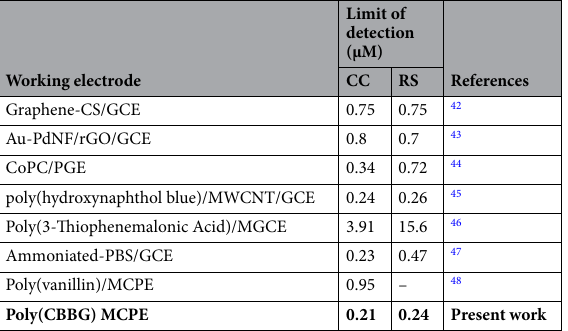
Table 1. Comparison of LOD at poly(CBBG)/MCPE with other reported modified electrodes for the determination CC, RS and HQ.